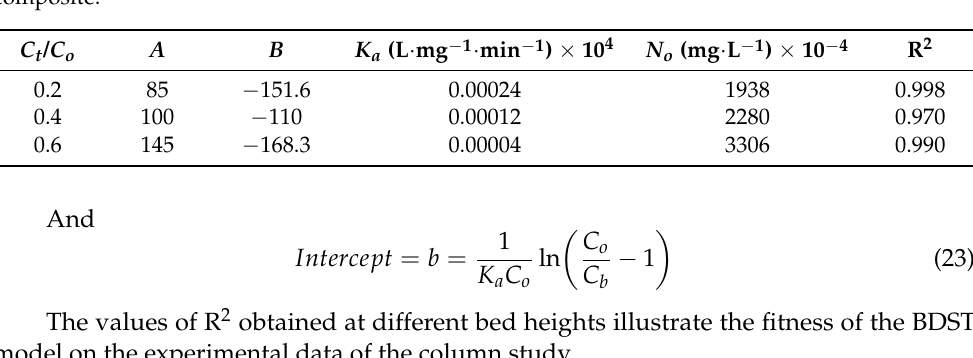
Table 6. BDST model parameters for the adsorption of 2,4,6-TCP onto FeCl 3 -NaBH 4 /MS hybrid